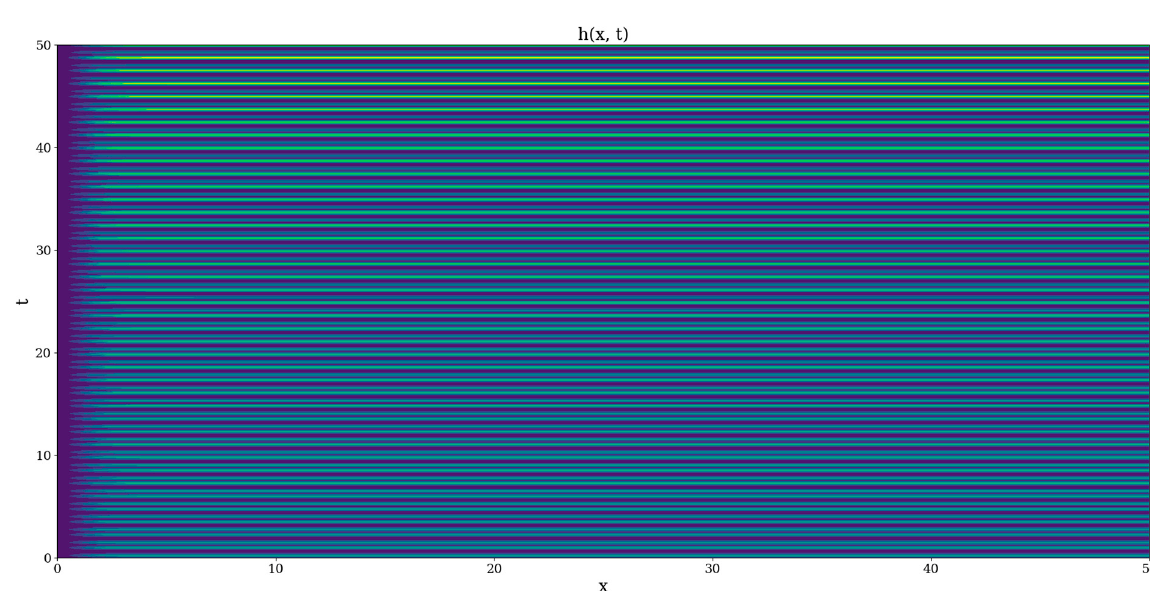
Figure 1. Example plot of h(x,t); ω constant.